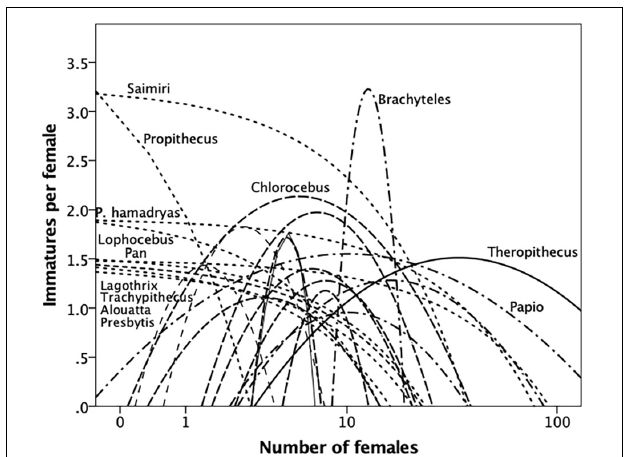
FIGURE 5 | Best-fit quadratic regressions for reproductive output (surviving immatures per female) regressed on female group size for different genera of primates. Lines in different format indicate clustering of regressions (for further details, see text and Supplementary Material ). Source: Supplementary Dataset 4